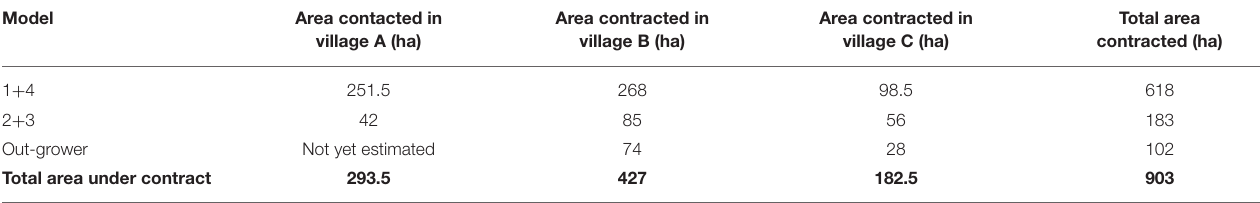
TABLE 3 | Area included in biofuel contract signed by company and village